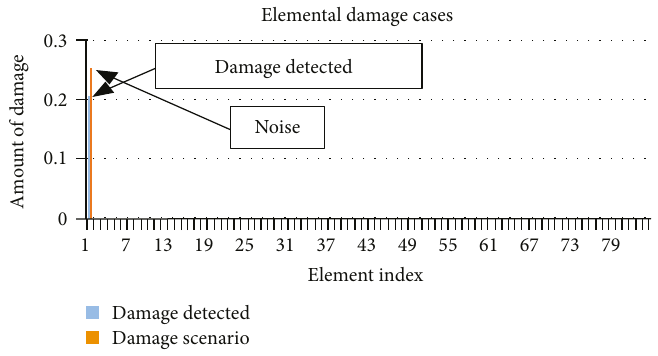
Figure 5: Damage positions in damage scenario 1 with noisy MSs.